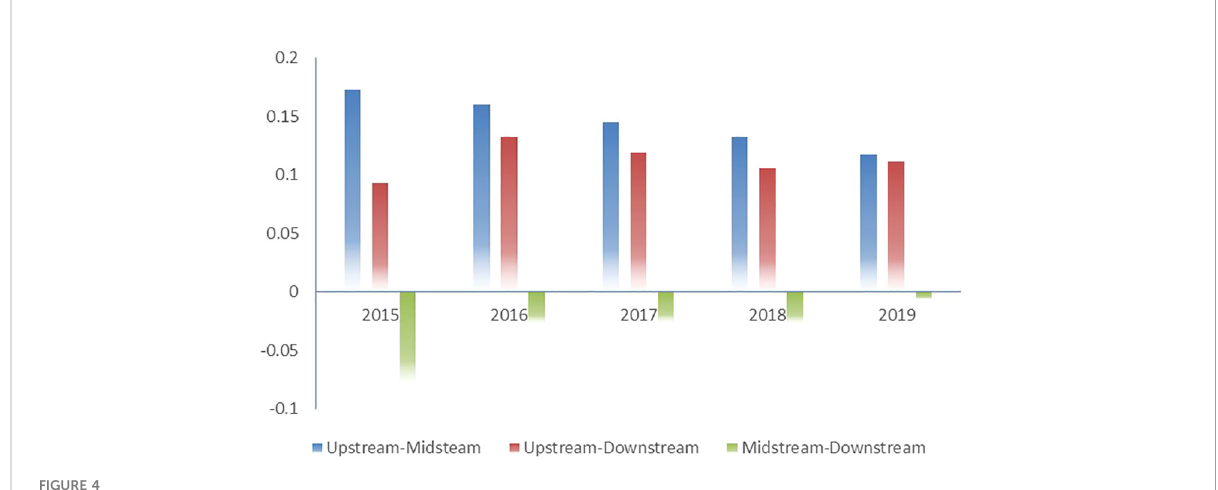
FIGURE 4 Technology gap between industry chain links, 2015-2019.